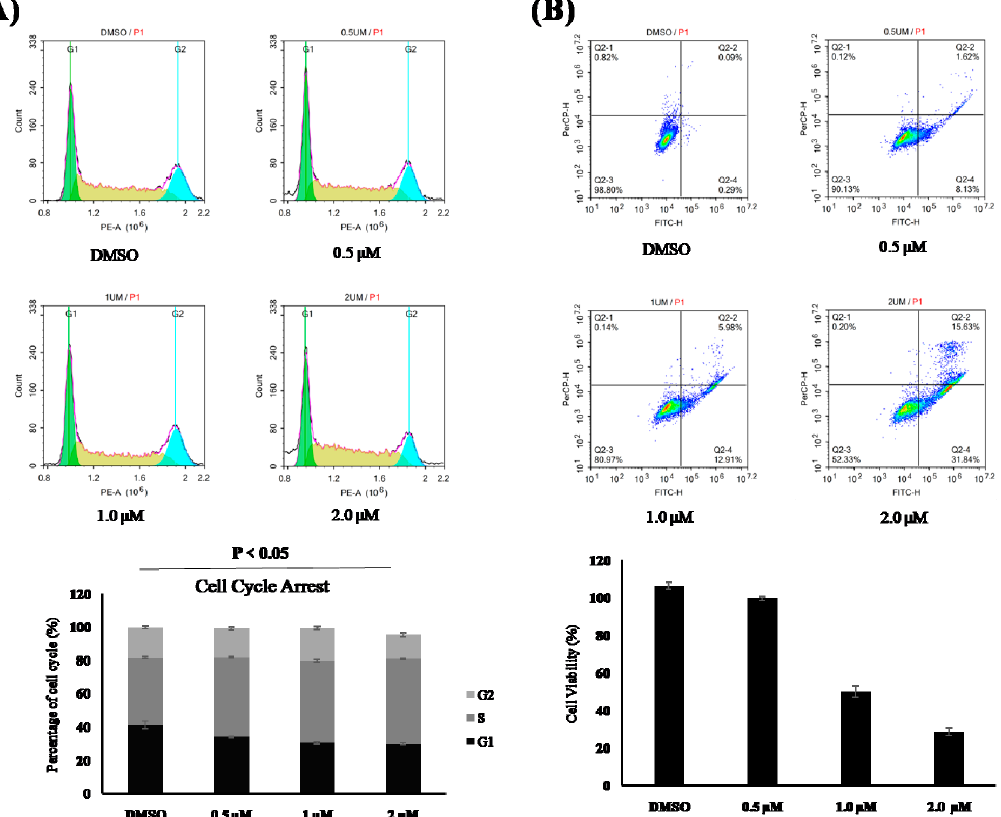
Figure 4. Apoptosis induced by compound 3f in HEL cell line. ( A ) Compound 3f had effect in retardation of cell cycle progression in HEL cell line. The cell cycle progression was retarded in the G1/S phase. HEL cell line was treated with compound 3f for 24 h. ( B ) Compound 3f induced apoptosis in HEL cell line. The HEL cell line was treated with compound 3f for 24 h and analyzed by flow cytometry, using Annexin V/PI staining.